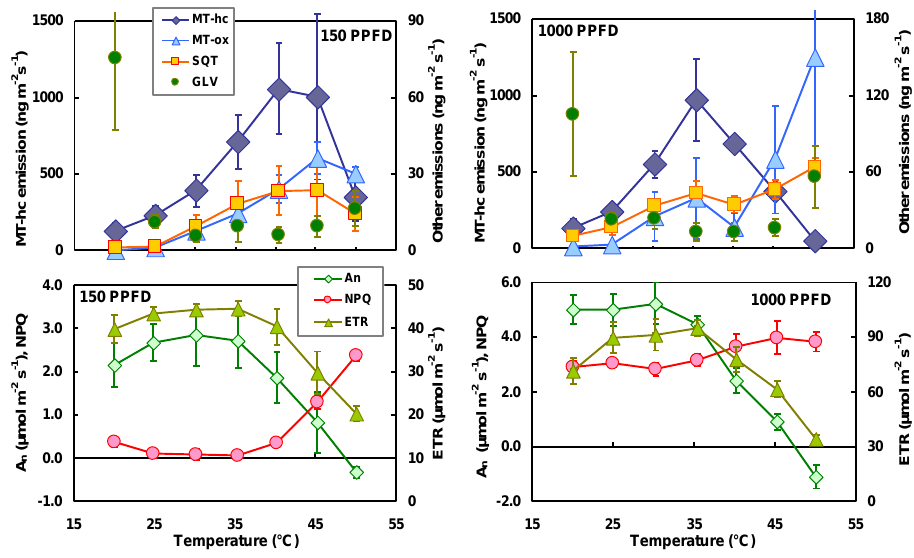
Fig. 2. Temperature responses of BVOC emissions (upper panels) and photosynthetic parameters (lower panels) of Q. coccifera leaves measured at two light levels of 150 (left panels) and 1000 (right panels) µmolm − 2 s − 1 PPFD. Dark blue lozenges: monoterpene hydrocarbons (MT-hc); bright blue triangles: oxygenated monoterpenes (MT-ox); yellow squares: sesquiterpenes (SQT); dark green circles: green leaf volatiles (GLV); dark green lozenges: photosynthesis ( A n ); green triangles: apparent photosystem II electron transport rate (ETR); red dots: non photochemical quenching (NPQ). Data are means ± SD of n =3